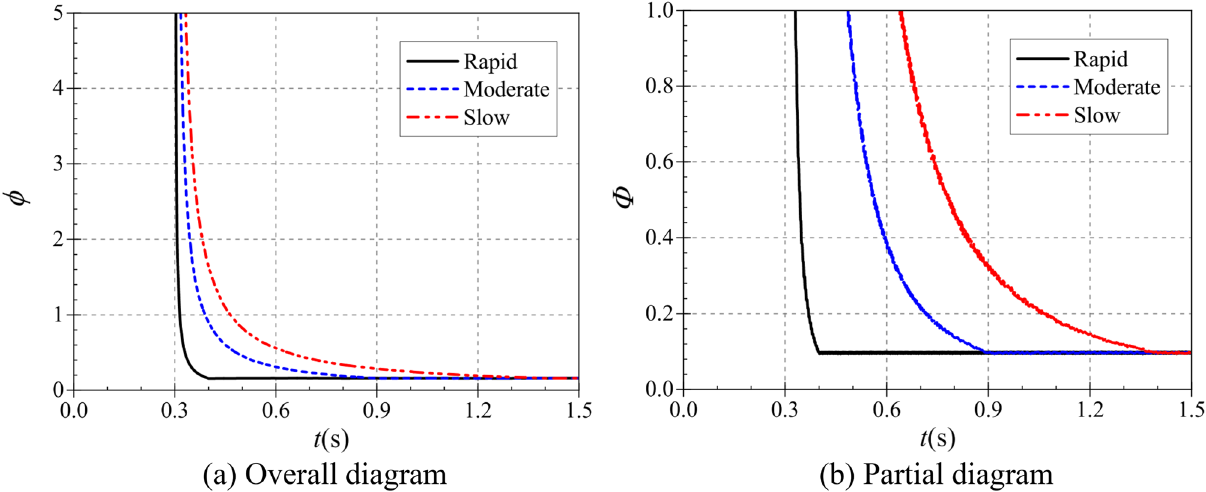
Figure 18. Dimensionless power coefficient. ( a ) Overall diagram, ( b ) Partial diagram.